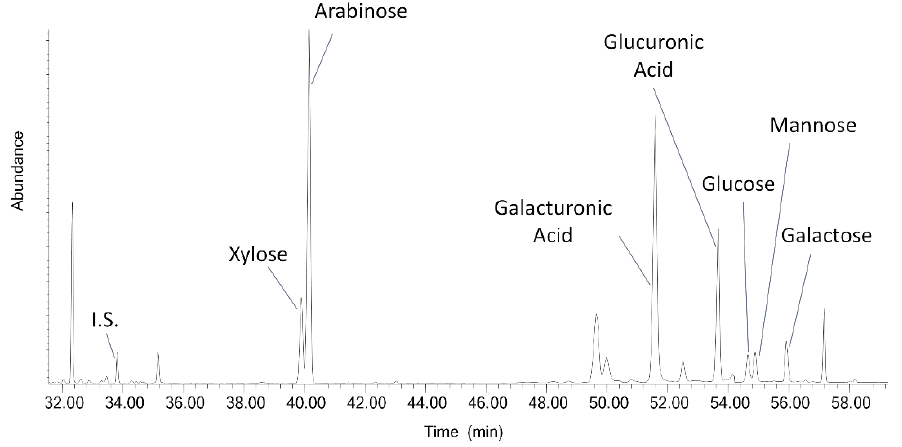
Figure 5. ATR-FT-IR spectrum of the preparation layer of a mural painting sample, recorded with 16 scans at 4 cm −1 spectral resolution. The bands associated with the presence of kaolinite (750, 784, 915, 1007, 1029, 3616, and 3686 cm −1 ) are highlighted with the asterisk (*), while those due to gypsum (595, 664, 1618, 3398, and 3529 cm −1 ) are labeled with the symbol (§). The optical microscope image of the sample is depicted on the top.